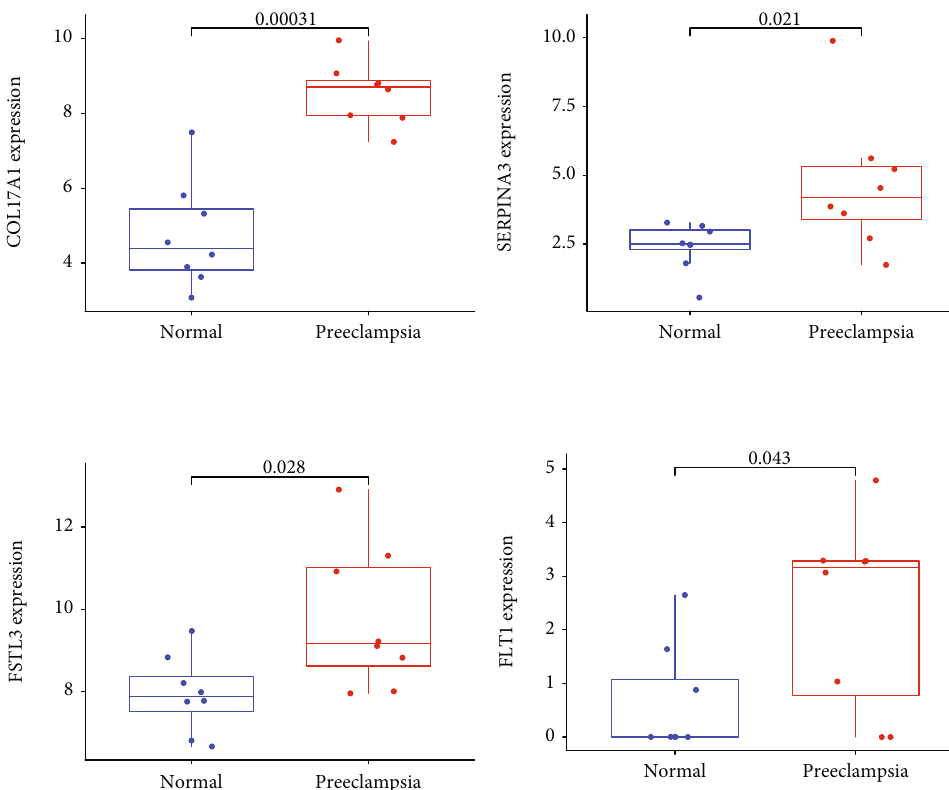
Figure 5: The expression pattern of the 9 critical genes was further demonstrated in GSE44711